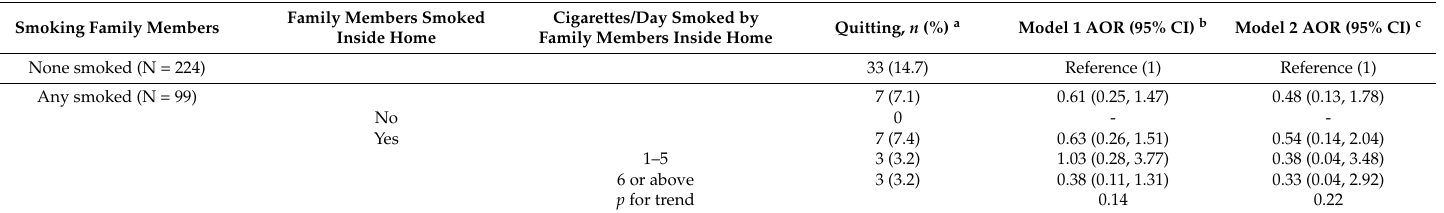
Table 3. Associations of second-hand smoke exposure at home and quitting at follow-up among 323 baseline daily smokers. Smoking Family